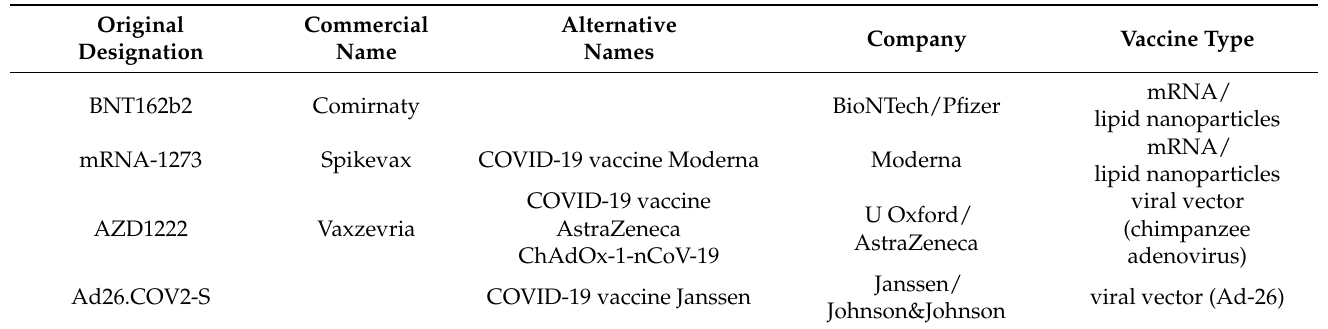
Table 1. Nomenclature of COVID-19 vaccines used in Europe and the